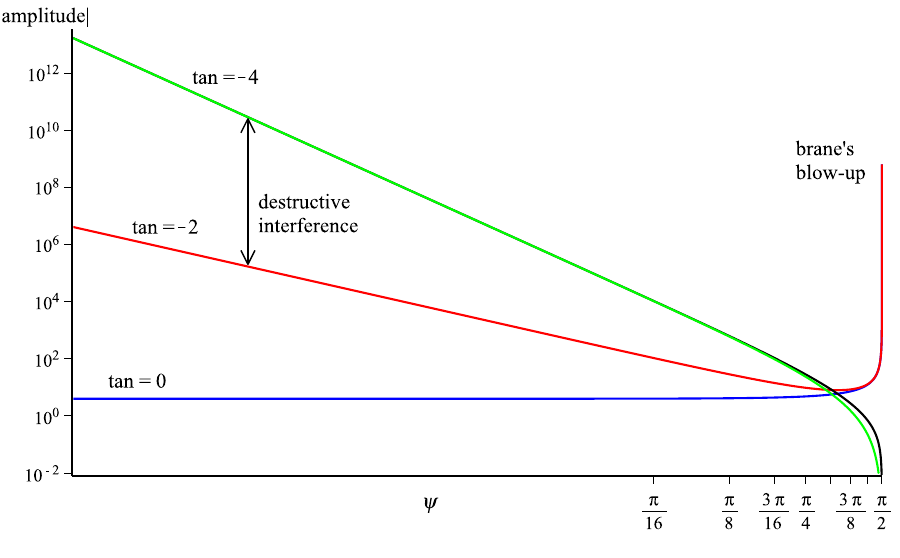
Figure 3 . Angular dependence of the (absolute values) radiation amplitudes for photon: particle (black), brane (blue) and stress (green) contributions and the total amplitude (red) in doubly logarithmic mode (in units C =